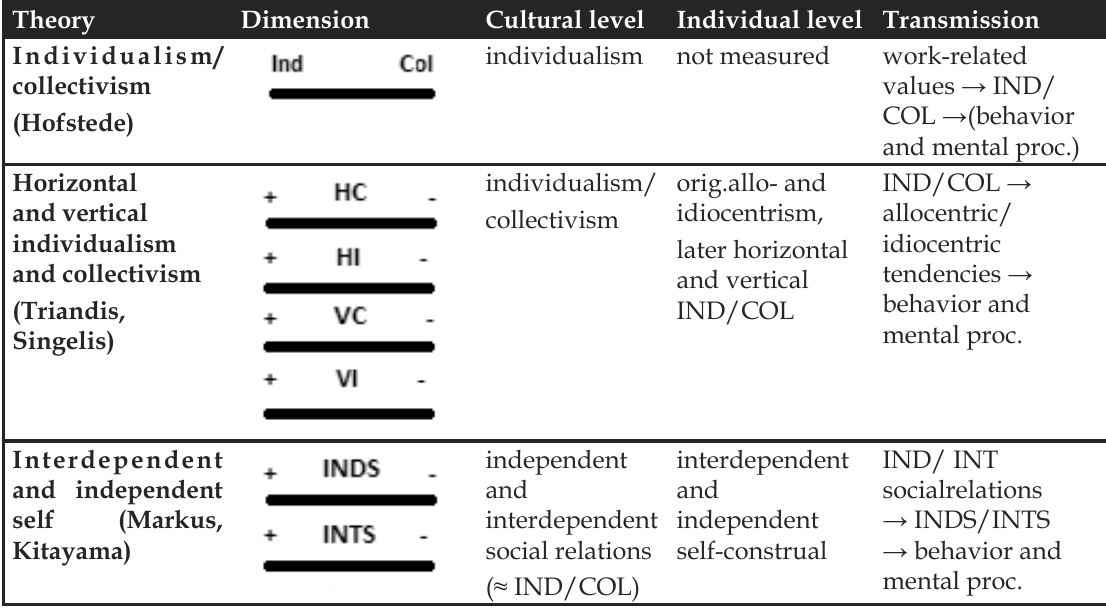
Table 2: Comparison of IND/COL